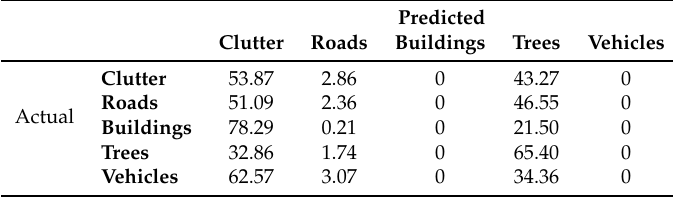
Table A3. Normalized confusion matrix for the GSCNN model that is trained on coordinates, after 50